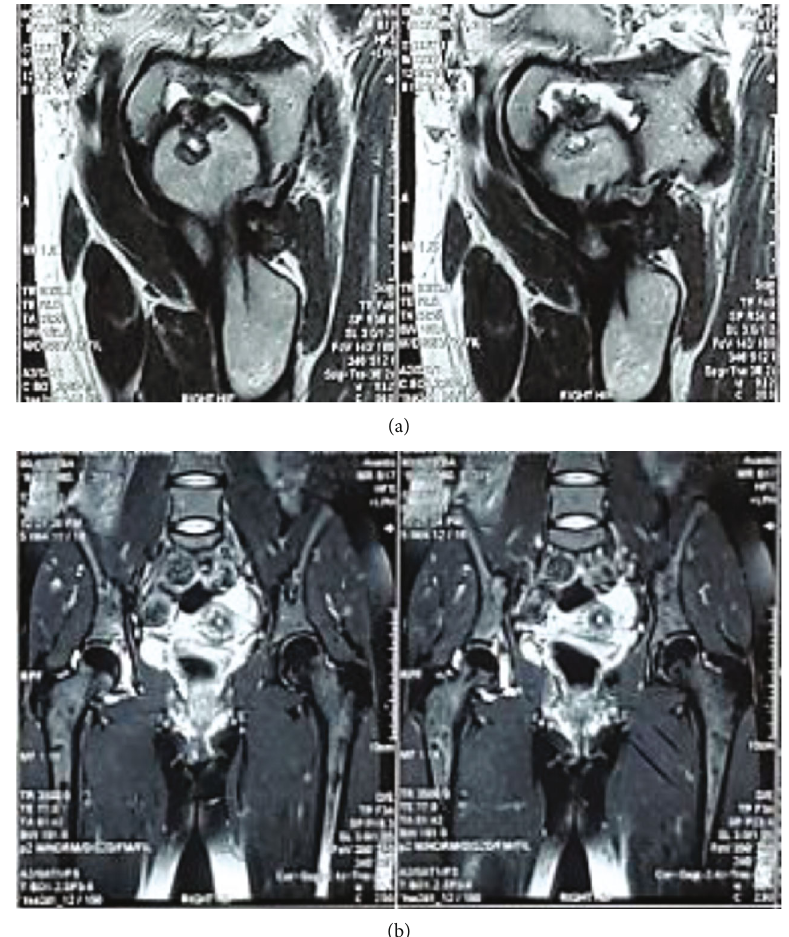
Figure 2: Synovium appears as hyposignal on T2-wieghted preoperative MRI in the sagittal plane and enhances after the gadolinium injection (a). Preoperative MRI showing the characteristic synovial process with low-signal intensity in fat-suppressed T2-weighted sequences (b).